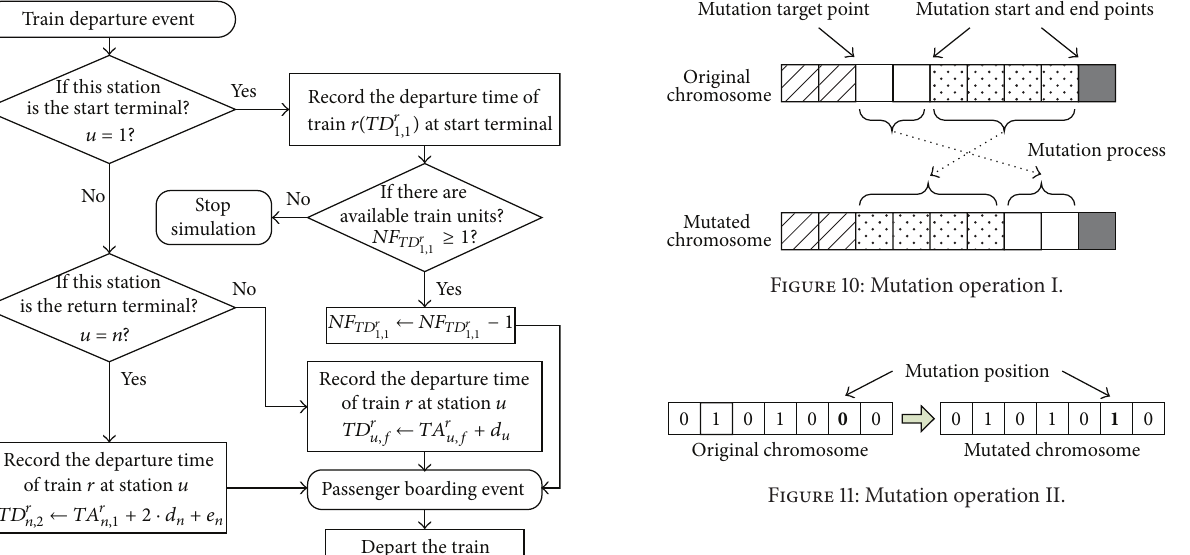
reduce the time spent to generate initial chromosomes. The